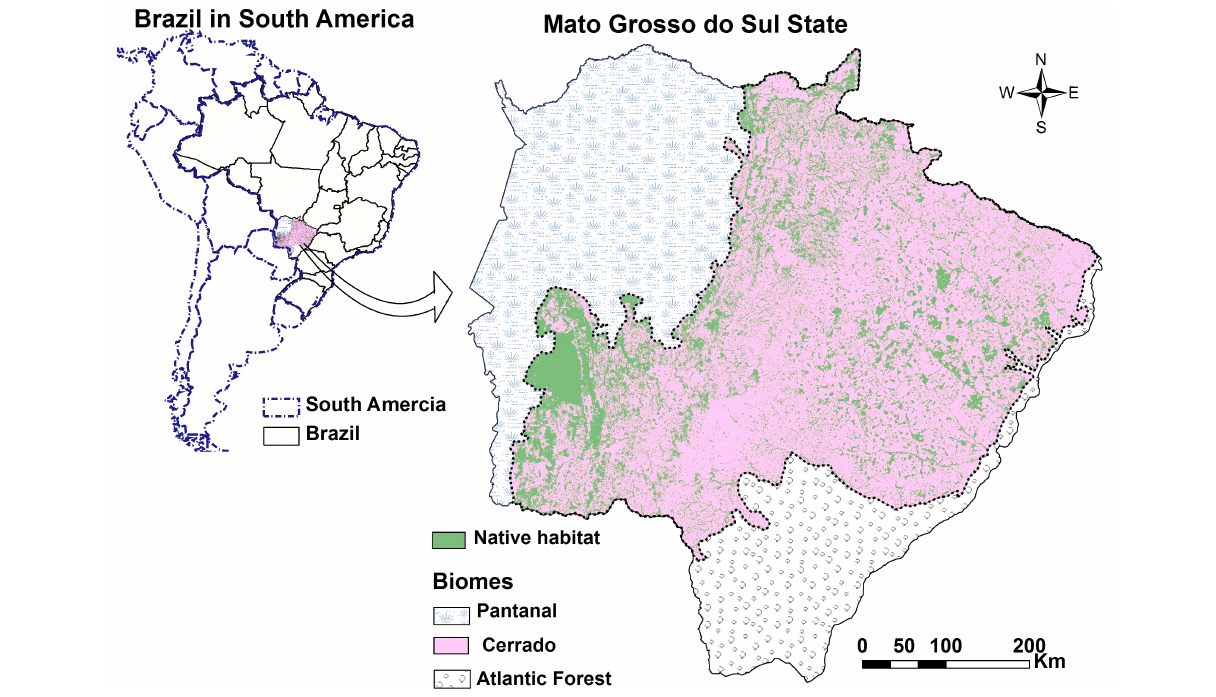
Fig. 1 . The study area is located in the Cerrado biome in Mato Grosso do Sul state, Brazil, comprising 61% of the state area. It is located in the central axis adjoining the Pantanal wetland and the Atlantic